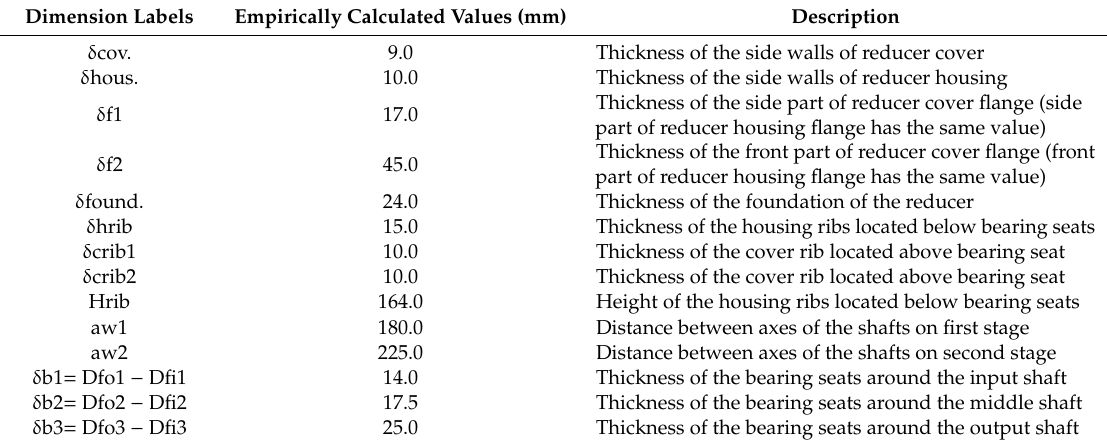
Table 1. Calculated dimensions’ values of the characteristic elements of the housing body and cover.